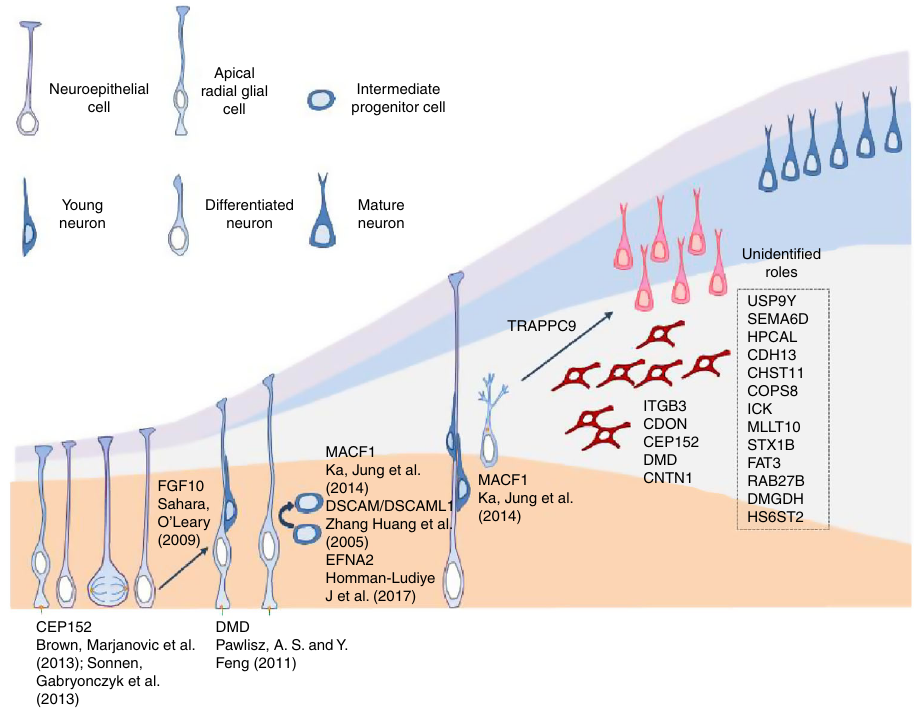
Fig. 7 Potential cellular roles of the candidate MCD genes involved in cortical development RGCs divide to self-renew and produce neural precursors in the VZ/SVZ. The progeny cells then migrate along radial fi bers to the CP and differentiate into neurons. Known (with references) roles for the candidate MCD genes are indicated. The roles of potential new genes in cortical development on right remain to be